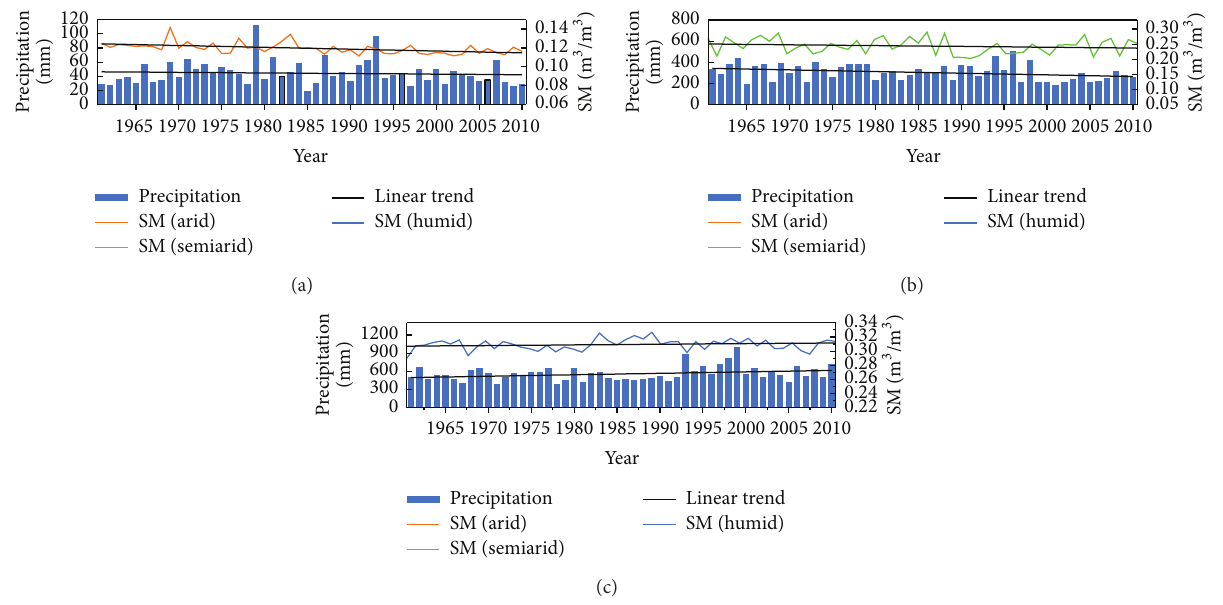
Figure 7: Intercomparison of the variation trends between the simulated SM and forcing precipitation in summer (June–August) in typical regions for the period 1961–2010. (a) Arid region; (b) semiarid region; and (c) humid